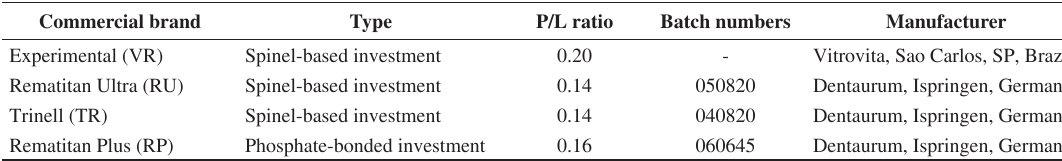
Table 1. Investment materials studied.